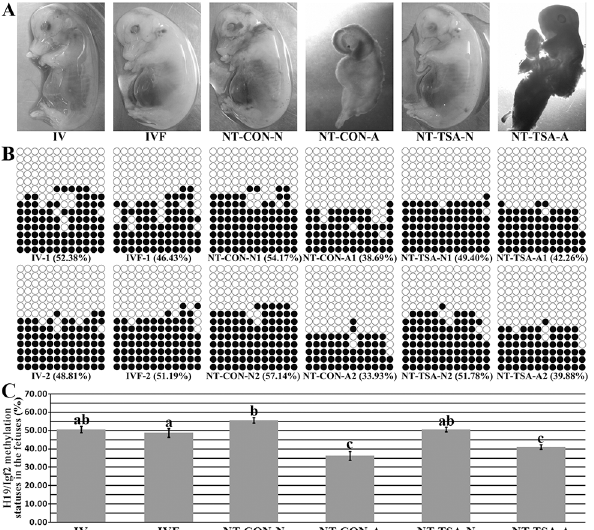
the IVF fetuses, NT-CON-N, the normal cloned fetuses in the NT-CON group, NT-CON-A, the abnormal cloned fetuses in the NT-CON group, NT-TSA-N, the normal cloned fetuses in the NT-TSA group, and NT-TSA-A, the abnormal cloned fetuses in the NT-TSA group. TSA prevented the H19/Igf2 imprinting disruption and morphological abnormality of cloned fetuses. Black or white circles indicate methylated or unmethylated CpG sites. The data were expressed as mean ± SEM. a-c Values with different superscripts differ significantly (P < 0.05).